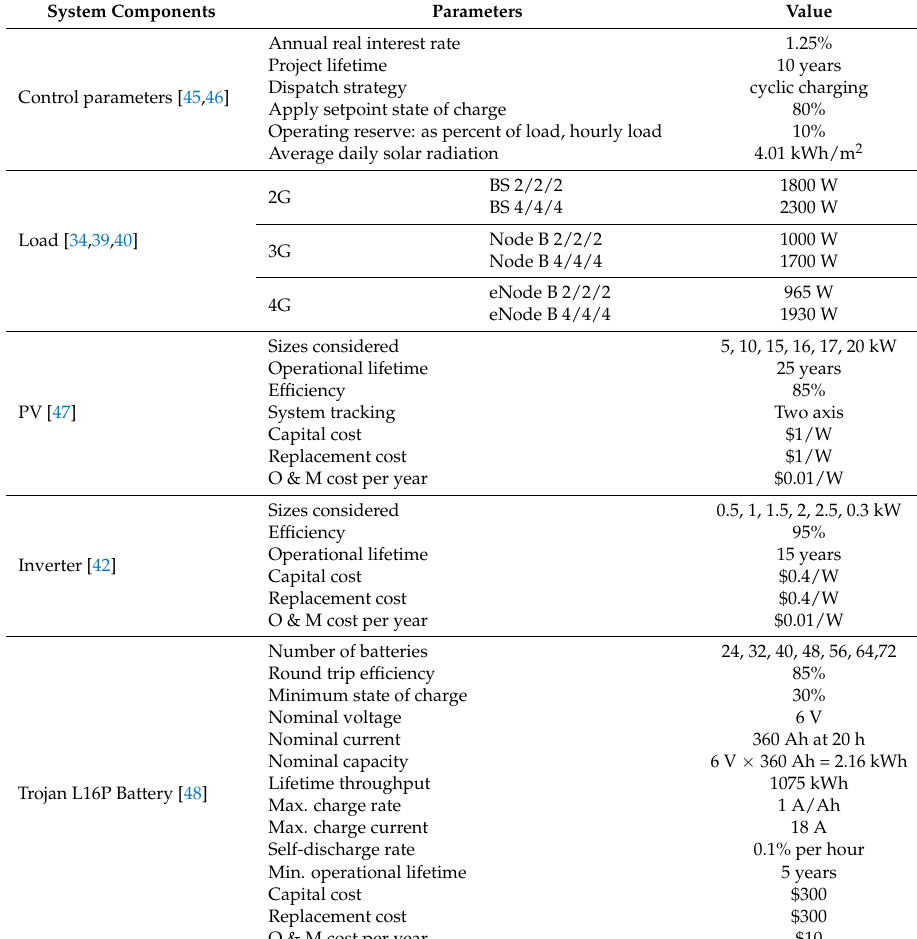
Table 2. The hybrid optimization model for electric renewables (HOMER) simulation